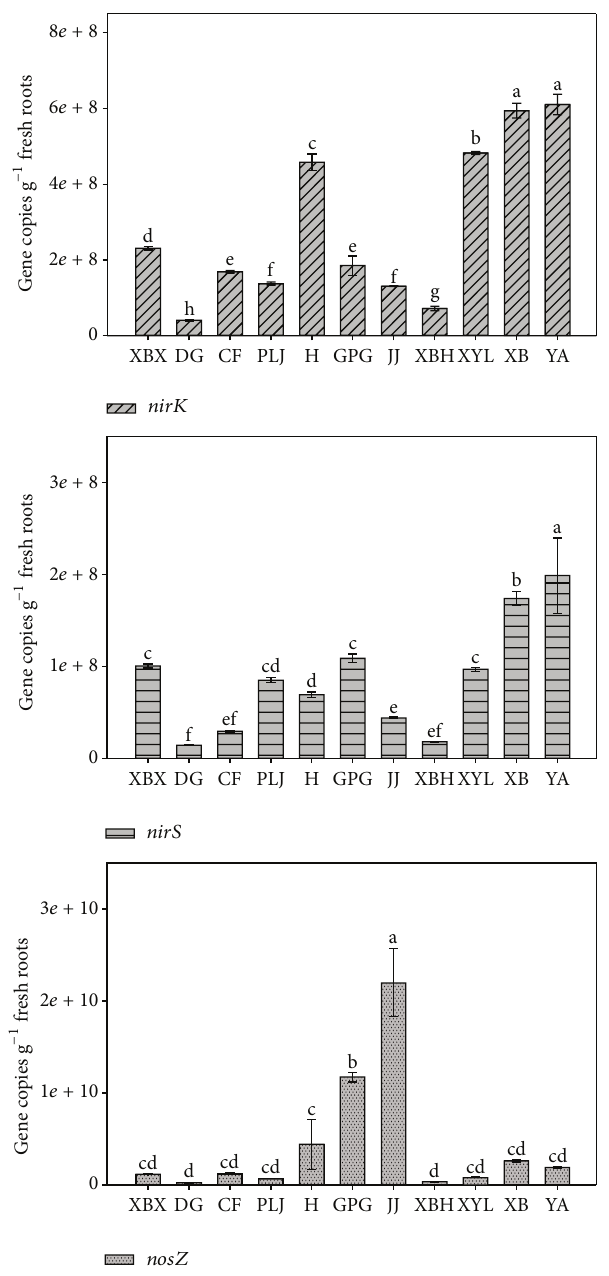
Figure 2: Abundance of nirS, nirK, and nosZ genes on the root of E. crassipes . Error bars indicate standard deviations ( 𝑛 = 3 ). The different letters indicate significant differences ( 𝑃 < 0.05